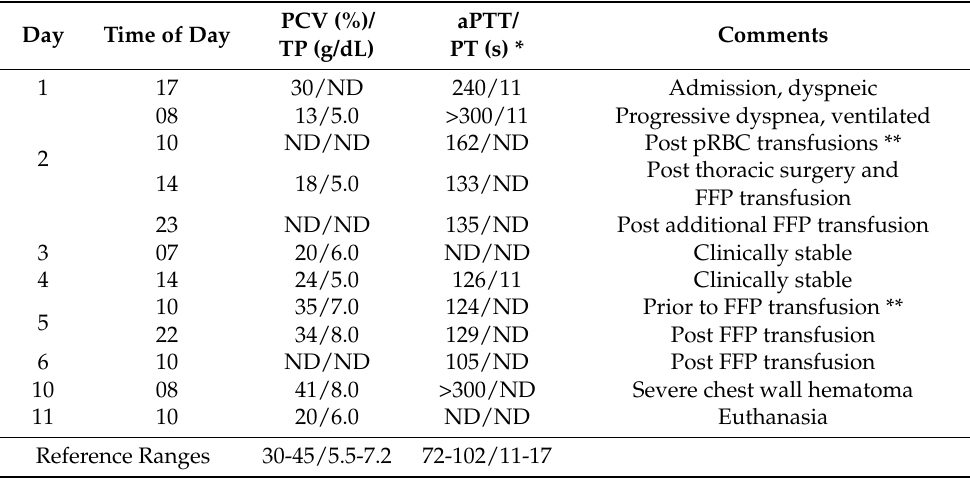
Table 1. Routine hemostasis test results for a bleeding male Newfoundland–Parti Standard Poodle puppy with hemophilia B: Case